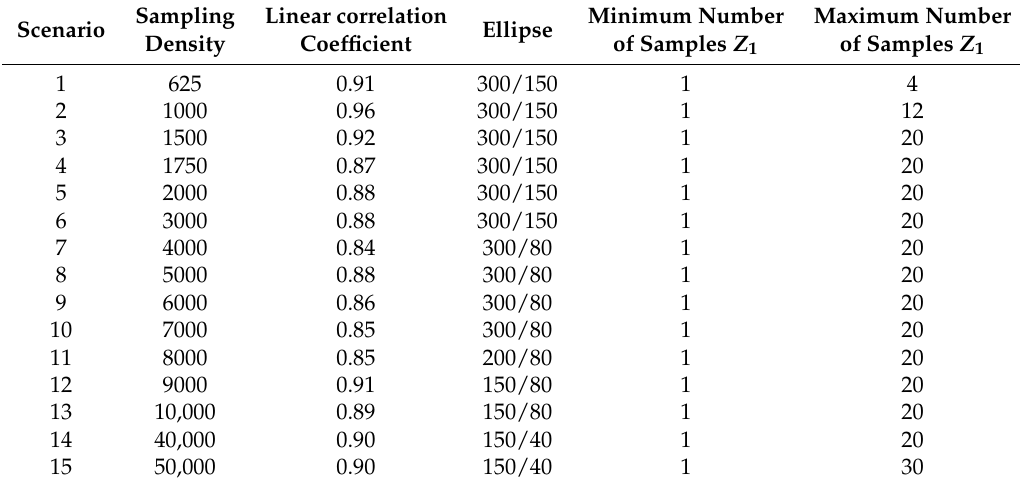
Table 5. Different scenarios depending on sampling